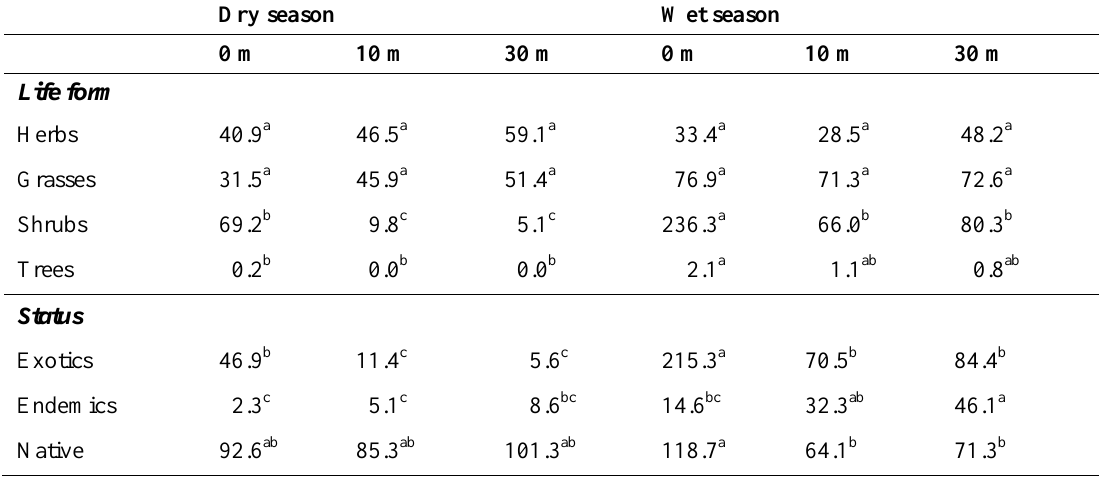
Table 1: Density of germinable seeds (per m 2 ) at 0 m, 10 m and 30 m distances away from the forest-grassland ecotone (FGE). Significant differences between distances and seasons are indicated using superscript letters for different life forms and ecological status, separately.